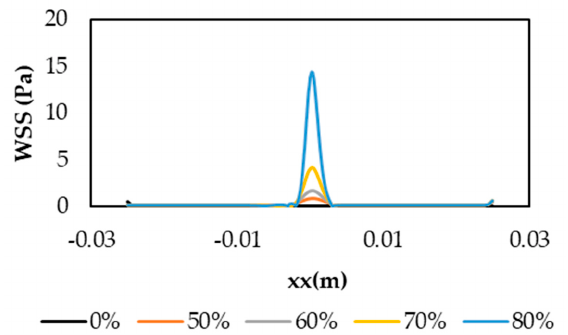
Figure 9. Wall Shear Stresses (WSS) distribution along the vessel Figure 9 . Wall Shear Stresses (WSS) distribution along the vessel wall.